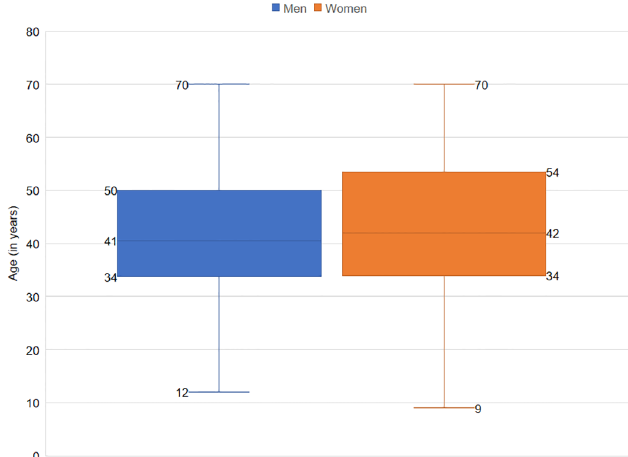
Fig 2. Age variation of sloth bear attack victims,